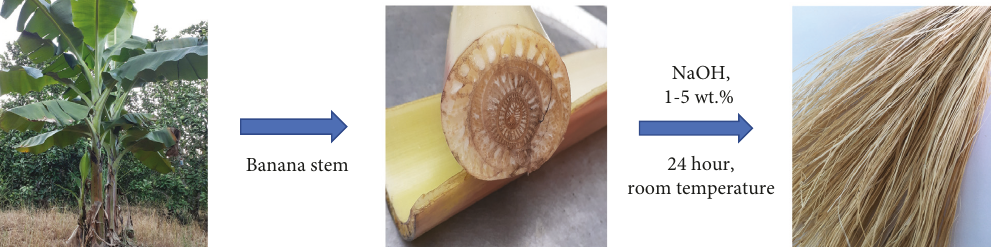
Figure 1: Retreatment process of Banana fiber